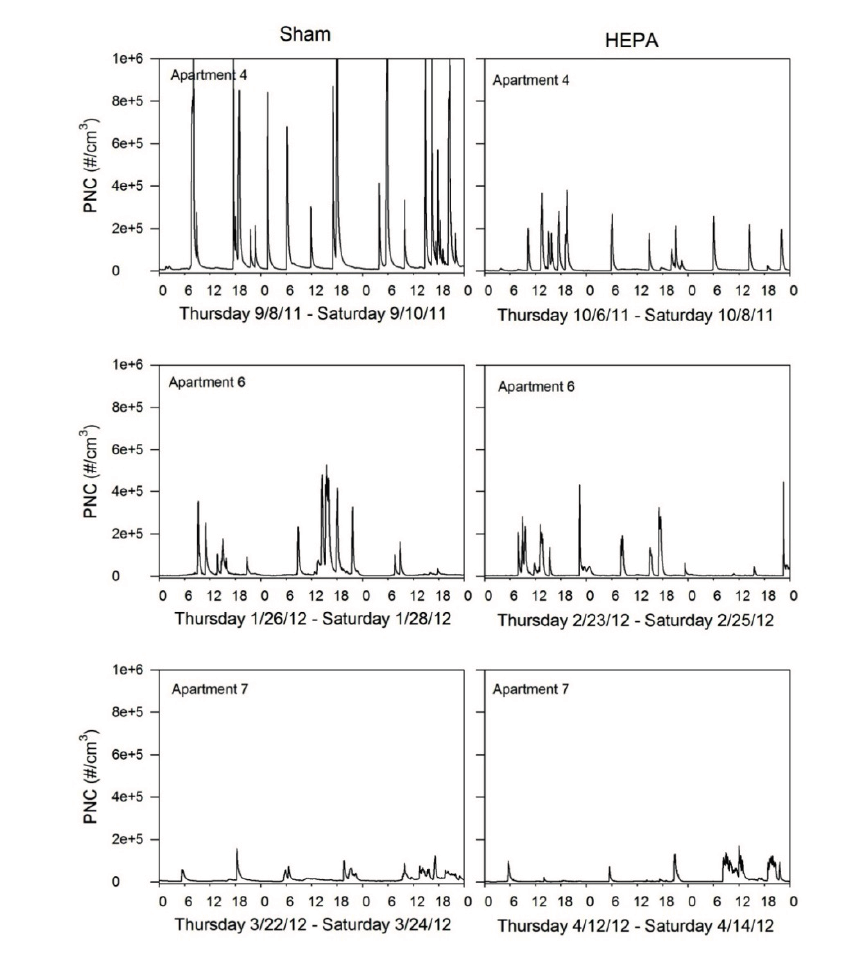
Figure A1. Time-series plots of 1-minute-averaged PNC for three apartments shows the impact of spikes presumably related to indoor activities such as cooking, cleaning, and candle and incense